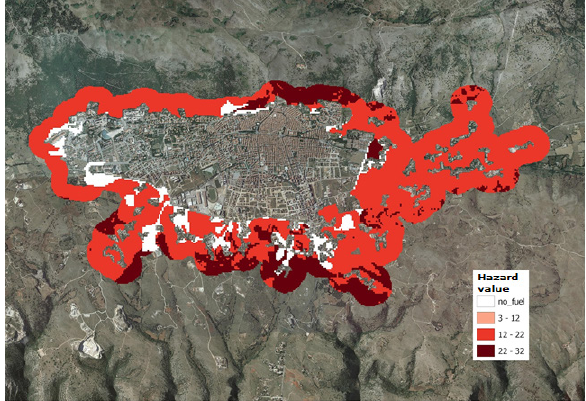
Figure 9 . Example of hazard calculation.